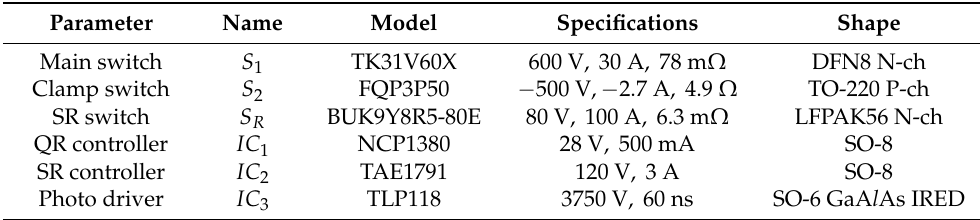
Table 2. Main devices and electrical ratings used in the experimental AC – DC adapters.